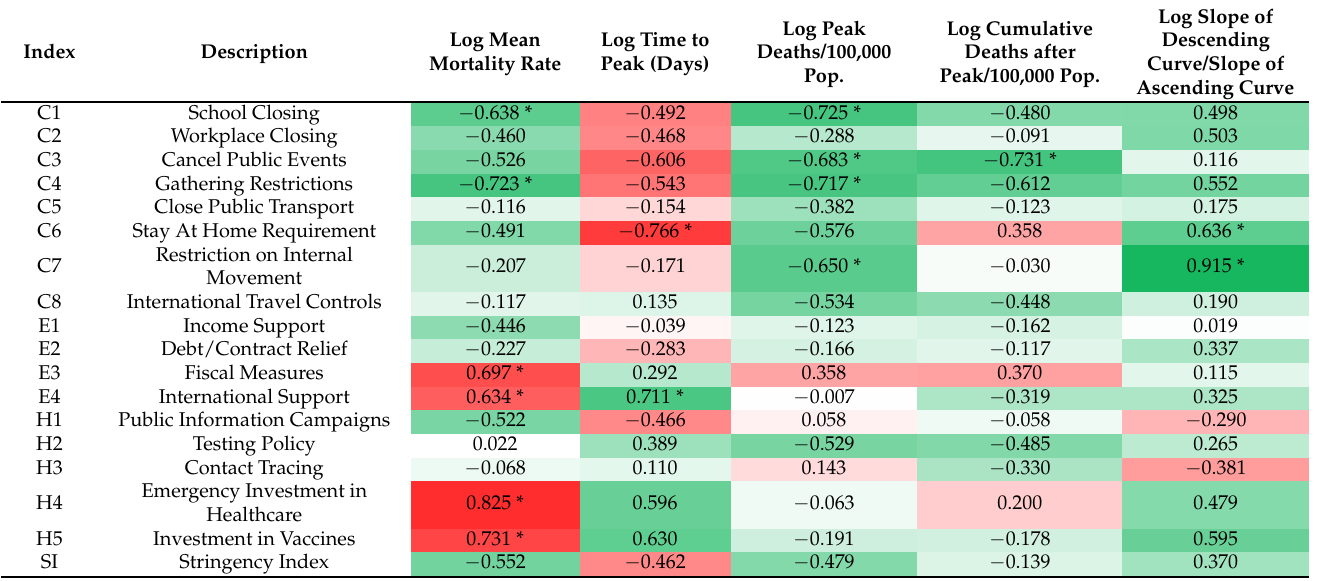
Table 5. Spearman rank-order correlation coefficient of policy indicators and the Stringency Index against five different measures of pandemic severity in high-income countries based on median GDP per capita (PPP).